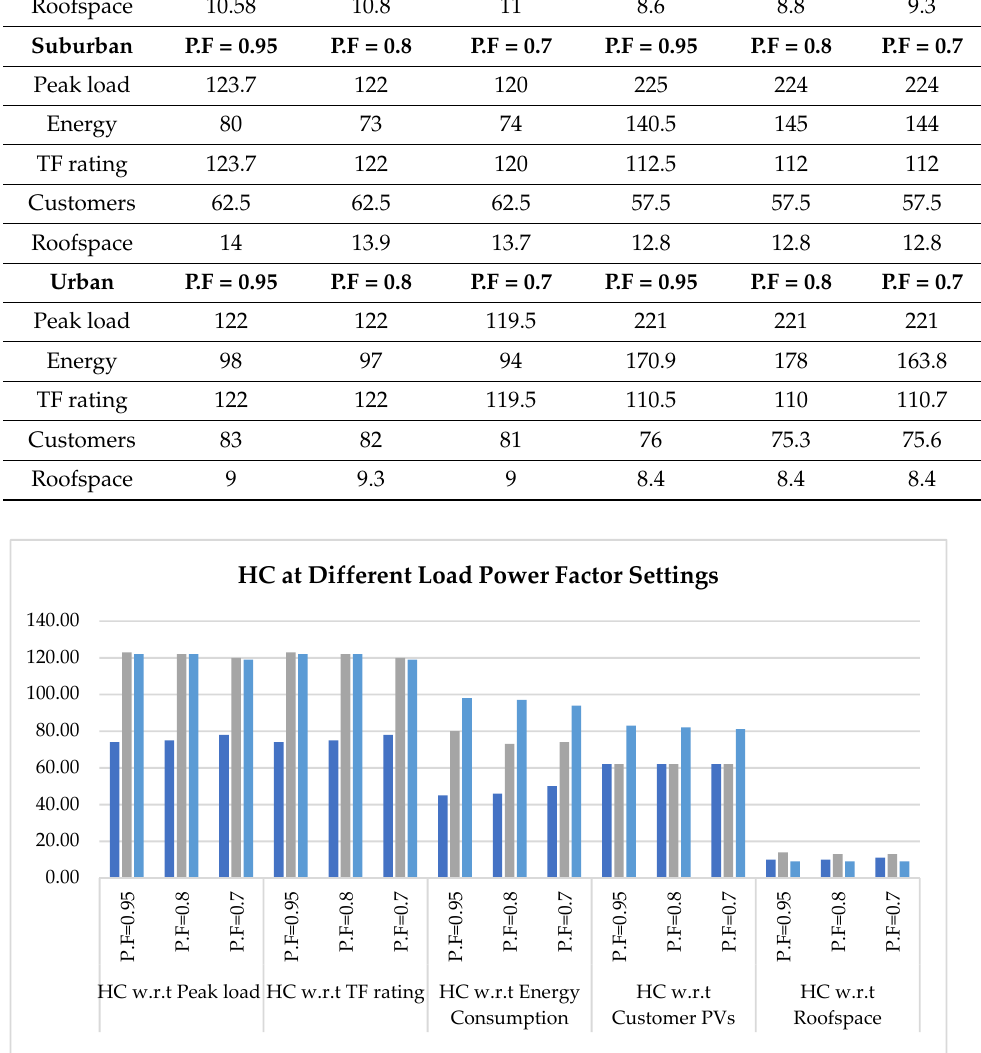
Table 7. The HC variation based on changing load power factor for 100% and 50% loading levels for balanced PVs in rural, suburban, and urban regions.